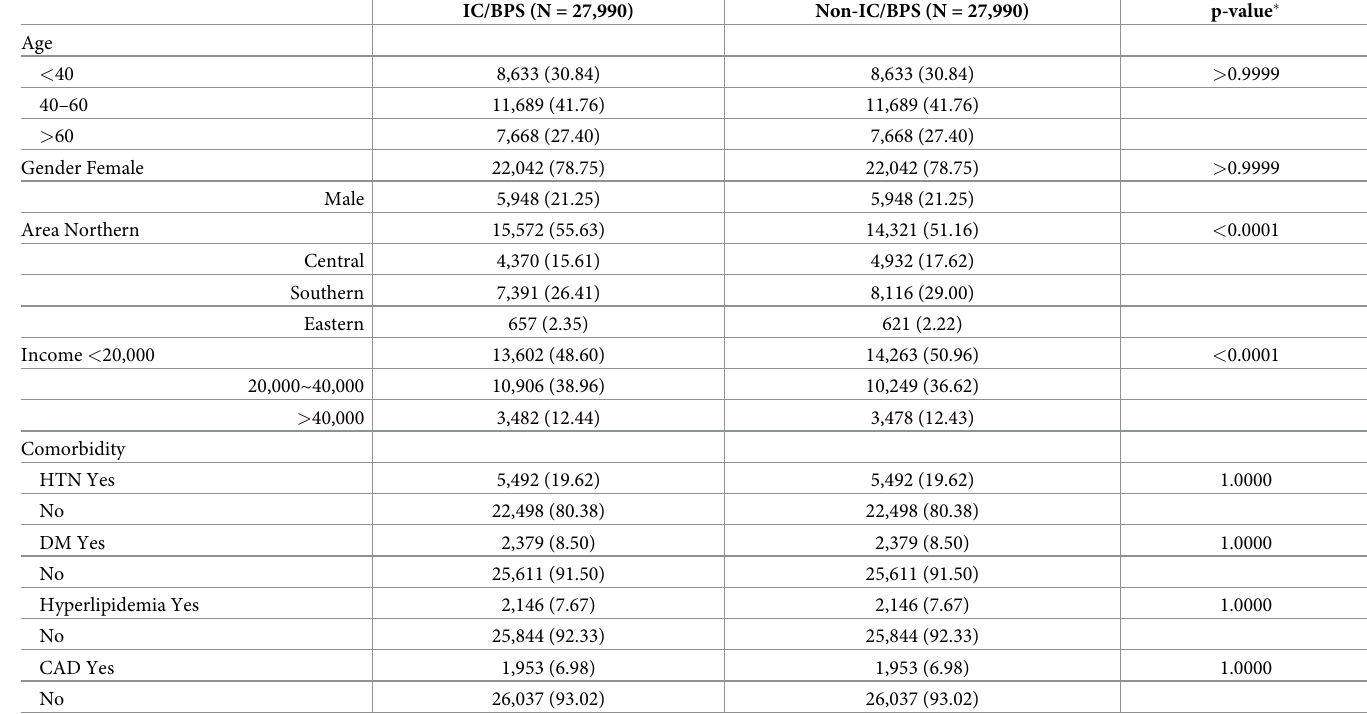
Table 1. Demographic information about interstitial cystitis/bladder pain syndrome (IC/PBS) patients and non-IC/PBS controls. IC/BPS (N = 27,990) Non-IC/BPS (N =